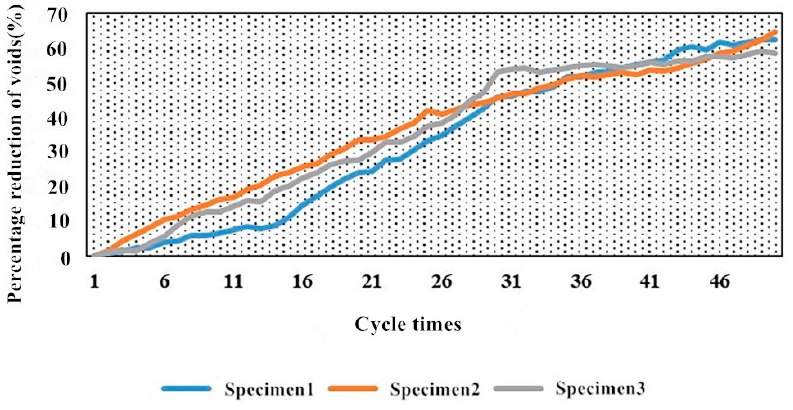
Figure 11. The change of void ratio reduction rate with the number of clogging cycles.